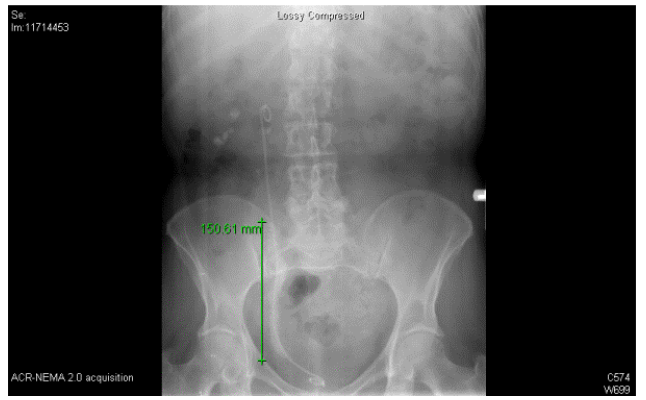
FIGURE 2. Plain radiograph demonstrating massive postoperative